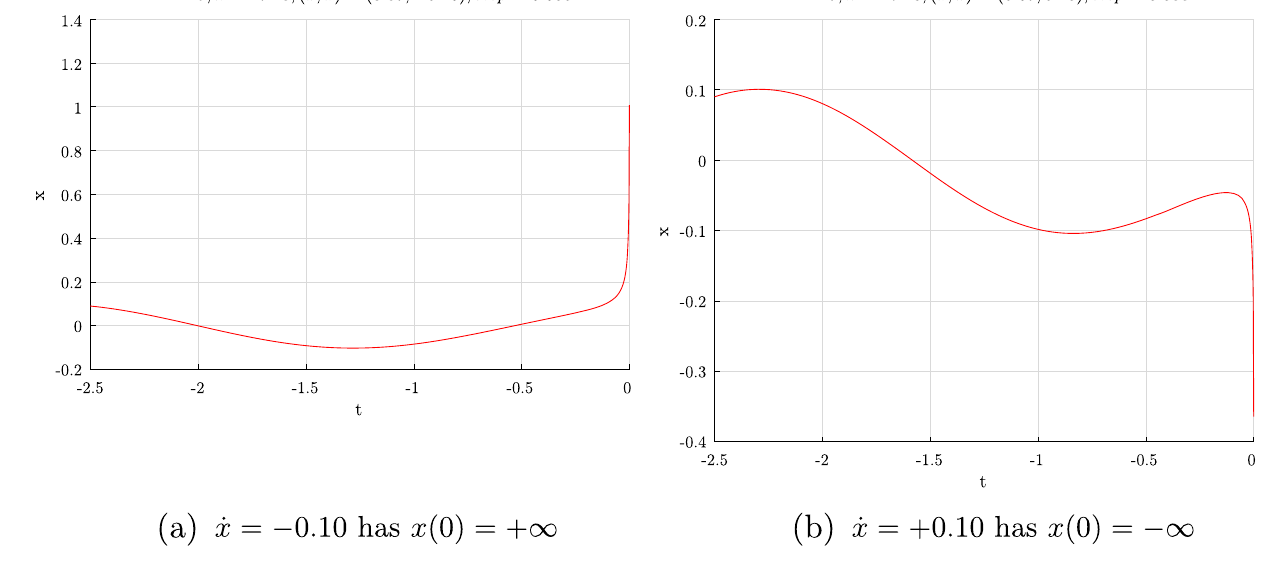
Fig. 1 Classical motion for L B with A > 1 has two possible asymptotic behaviors